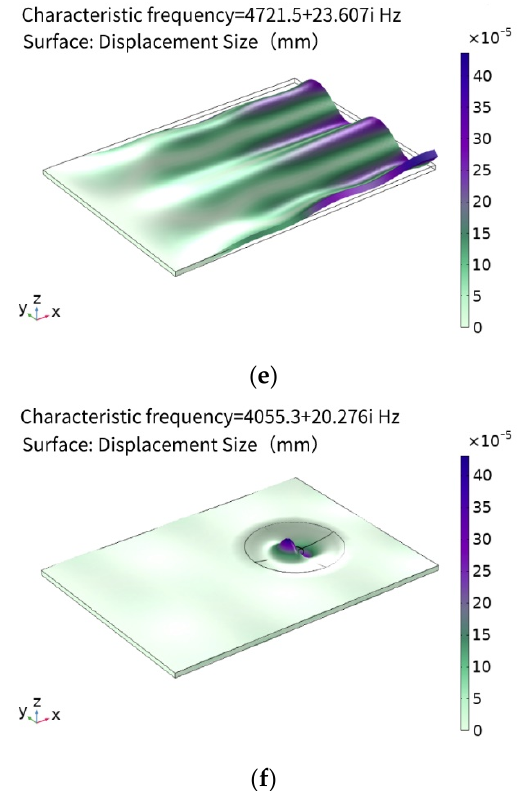
Figure 5. Modal comparison between flat plate and ABH plate. ( a ) Flat plate characteristic frequency 259.8 Hz, ( b ) ABH plate characteristic frequency 248.7 Hz, ( c ) flat plate characteristic frequency 2428.6 Hz, ( d ) ABH plate characteristic frequency 2309.6 Hz, ( e ) flat plate characteristic frequency 4721.5 Hz, and ( f ) ABH plate characteristic frequency 4055.3 Hz.